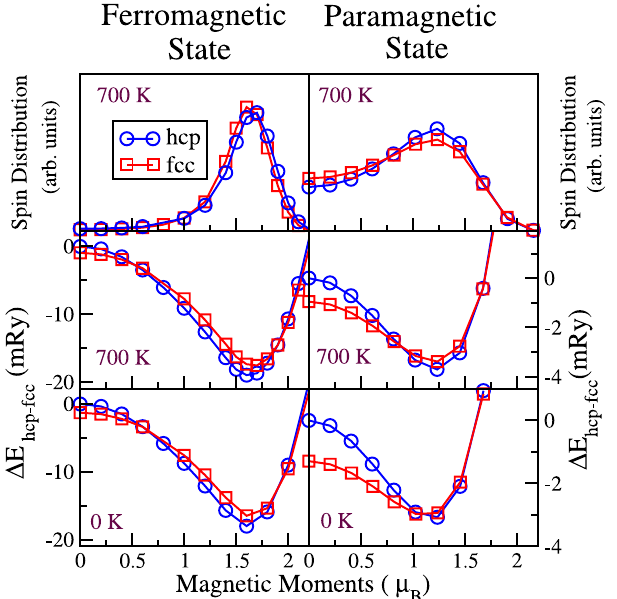
Figure 5. Results for the FM state and PM state are displayed in the left- and right-panels, respectively. In the top panel we show the spin density distribution for both hcp and fcc at 700 K. The bottom and middle panels show the fixed-spin total energies with respect to the hcp NM state, calculated for hcp and fcc at volumes corresponding to 0 K and 700 K,